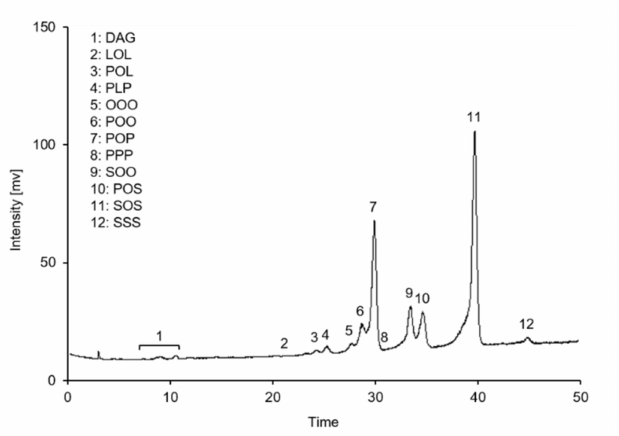
Figure 9. A typical high-performance liquid chromatography/evaporative light-scattering detector chromatogram of triacylglycerols contained in cocoa butter equivalents prepared in the present